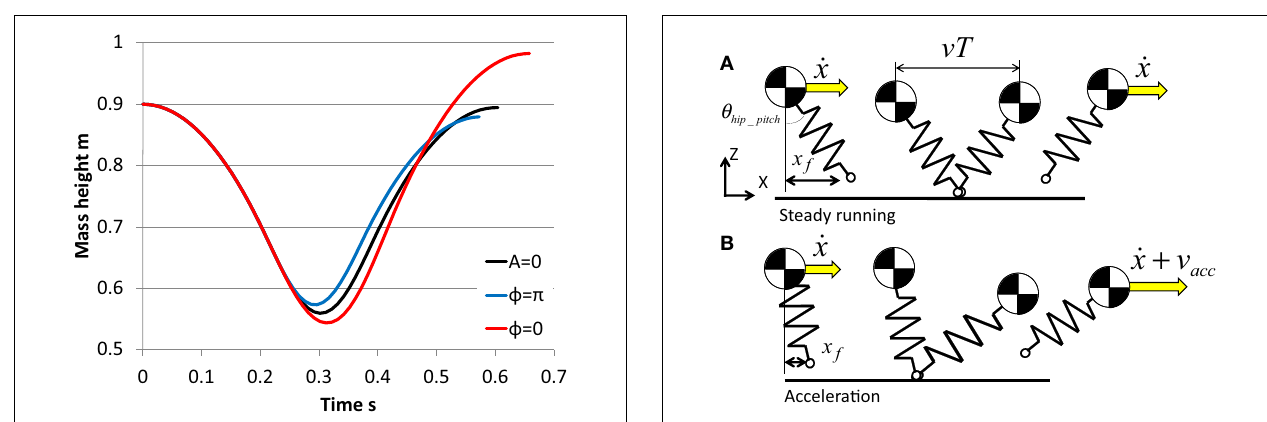
FIGURE 3 | Verification of the pelvic movement . We plotted the results until the mass height was at a peak after jumping. When the phase difference was 0rad, the mass height became higher than the fall height. On the other hand, when the phase difference was rad, the mass height after jumping became lower than that on the condition that the pelvic rotation amplitude 0°.